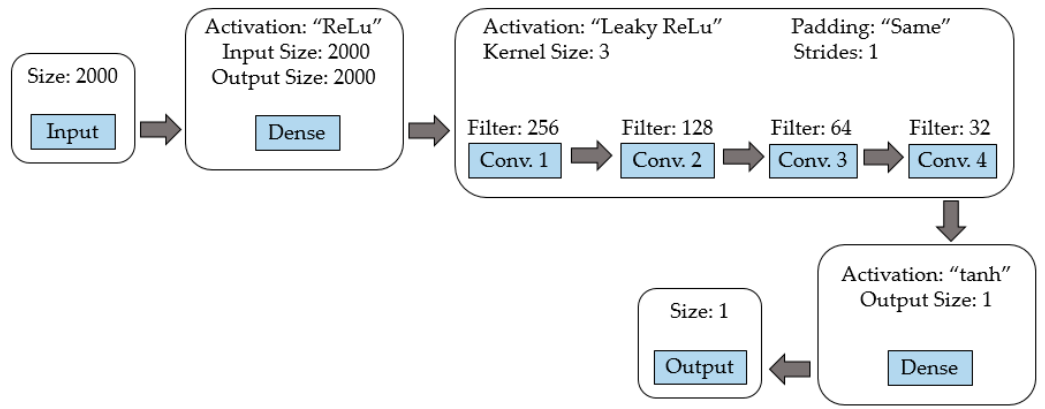
Figure 6. Architecture of the discriminator model.